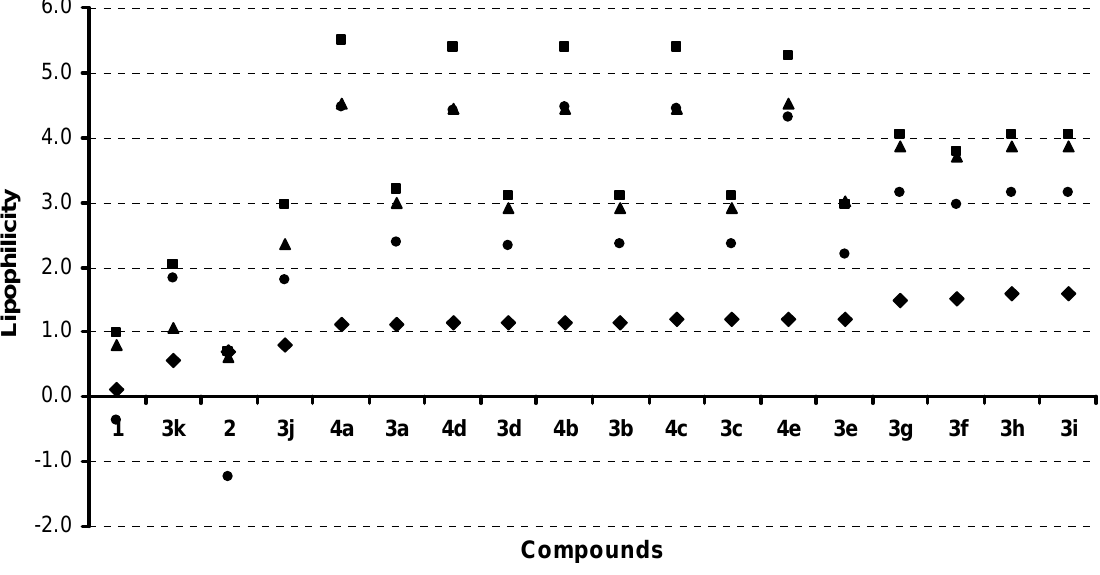
Figure 1. Comparison of the log P /Clog P values computed using the two programs with the calculated log k values. The discussed compounds 1 - 4e are ordered according to the increase in log k